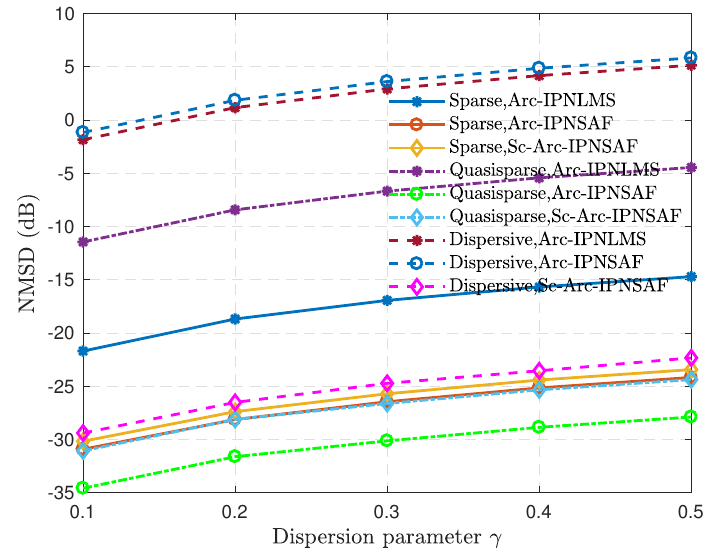
Figure 9. Steady-state NMSD with different λ for the AR(2)